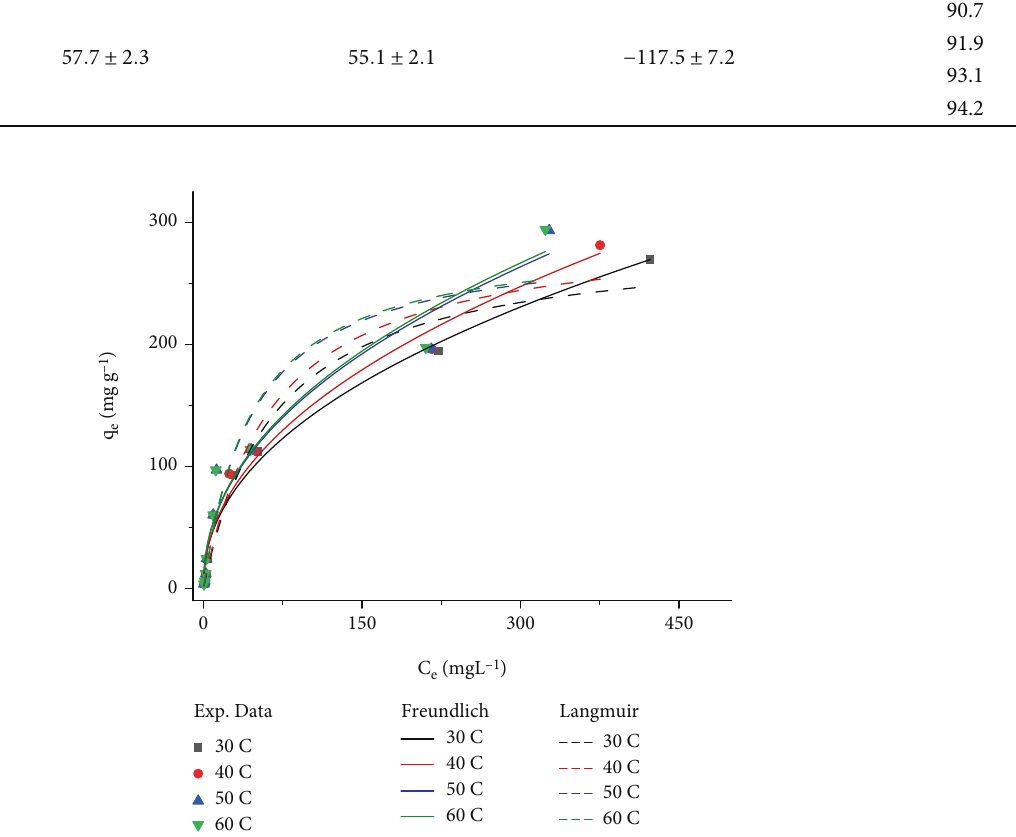
Figure 6: Langmuir and Freundlich adsorption isotherms for the adsorption of BF on GC (0.2 g GC, 150 mL BF, initial pH = 6 : 5 , stirring = 120rpm , di ff erent